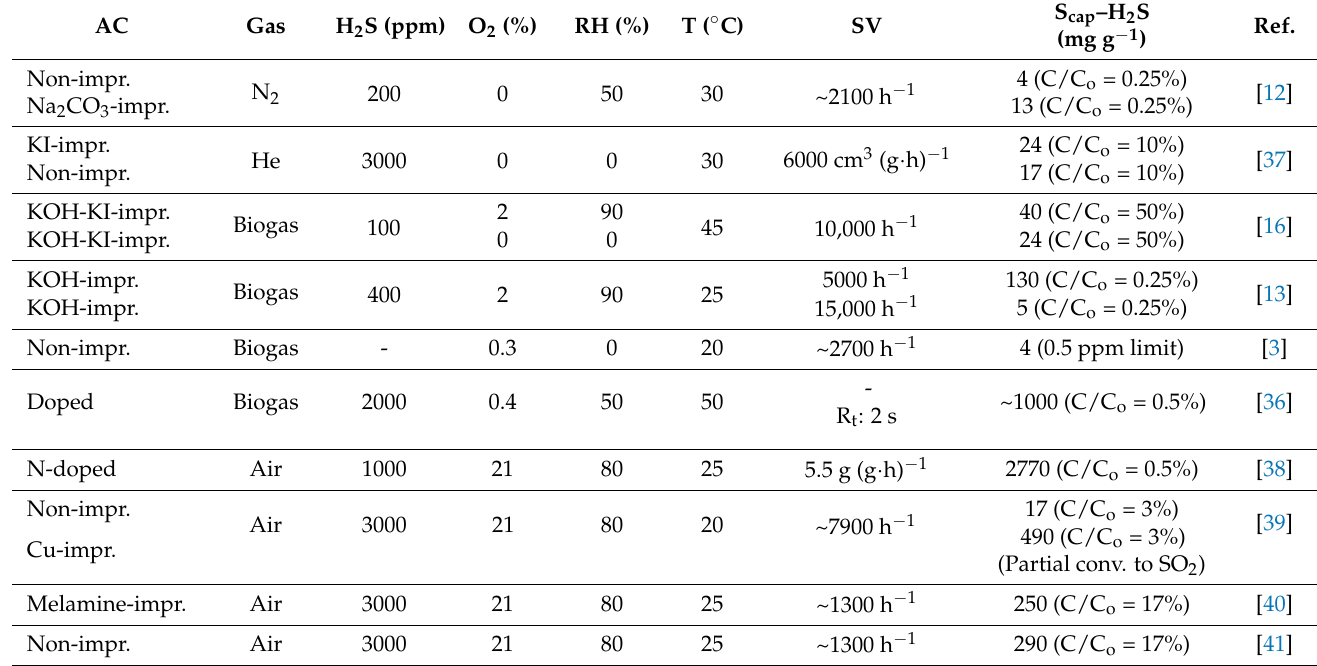
Table 3. Low-temperature dynamic lab-scale H 2 S breakthrough capacities and the main operating conditions from previous